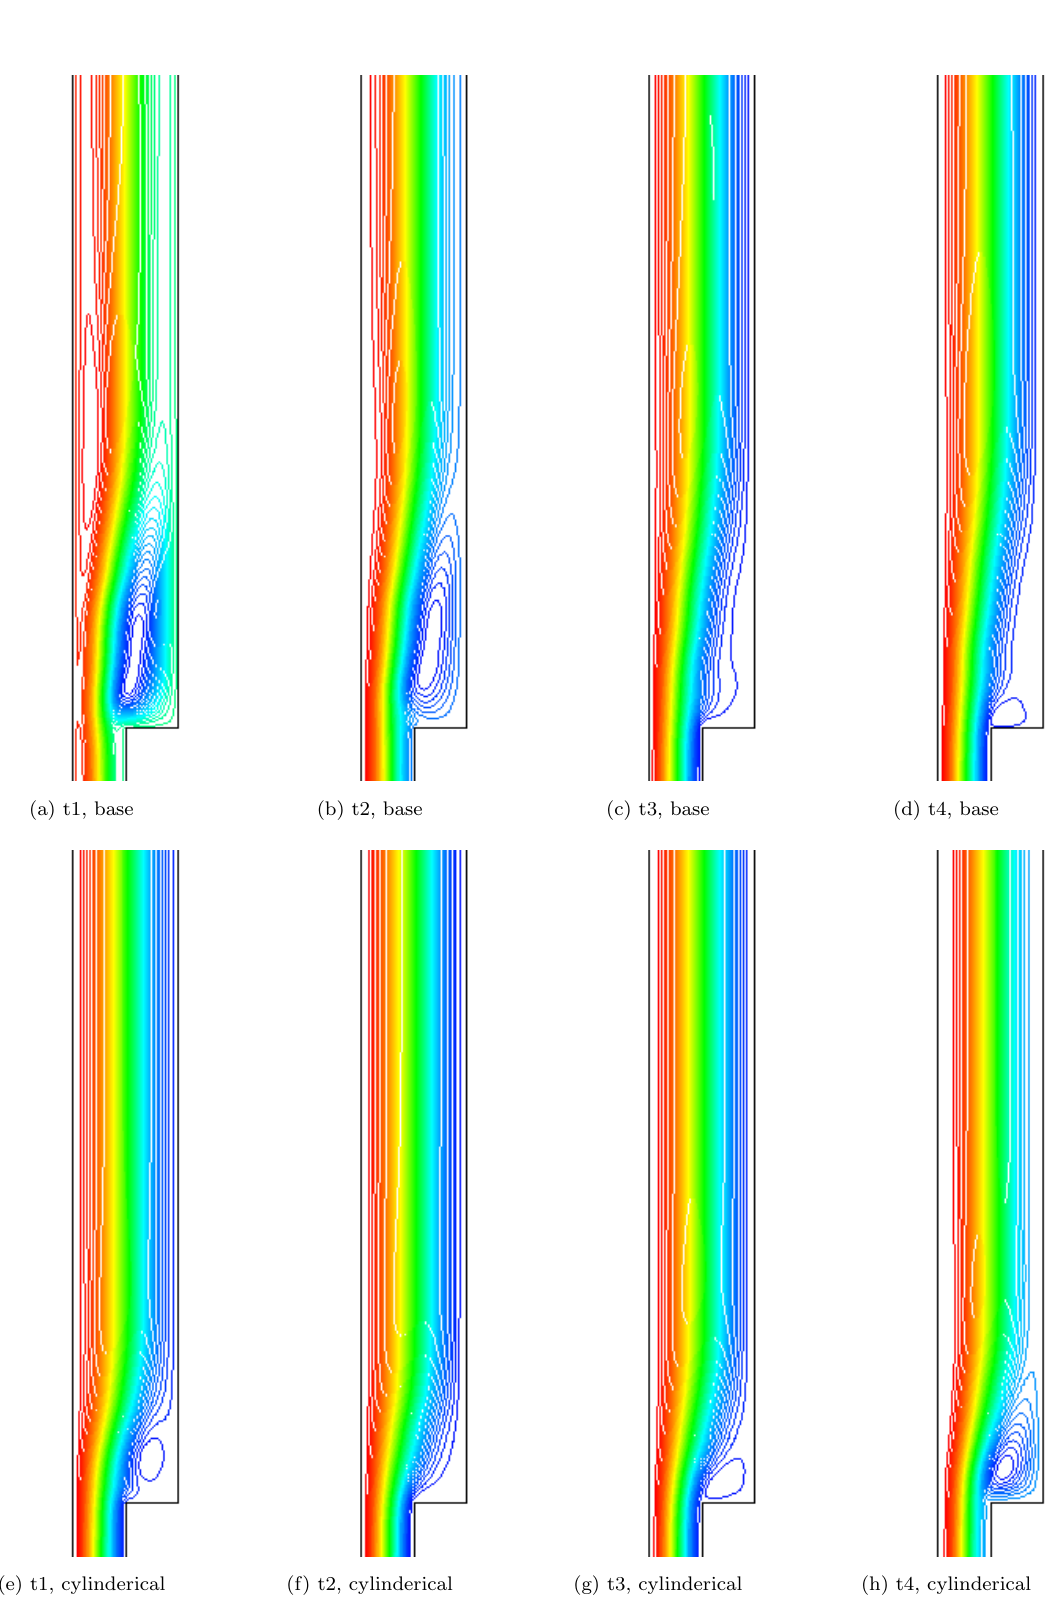
Figure 4: wall moves in negative x direction: Effects of varying Richardson number on the streamlines and isotherms for fixed values of (Ra I = 10 6 , E=1000, s l = 0 . 5 L ϕ = 0 . 02) Figure 6. Variation of streamlines for several time instances within a period for the base fluid and for the nanofluid with cylindrical